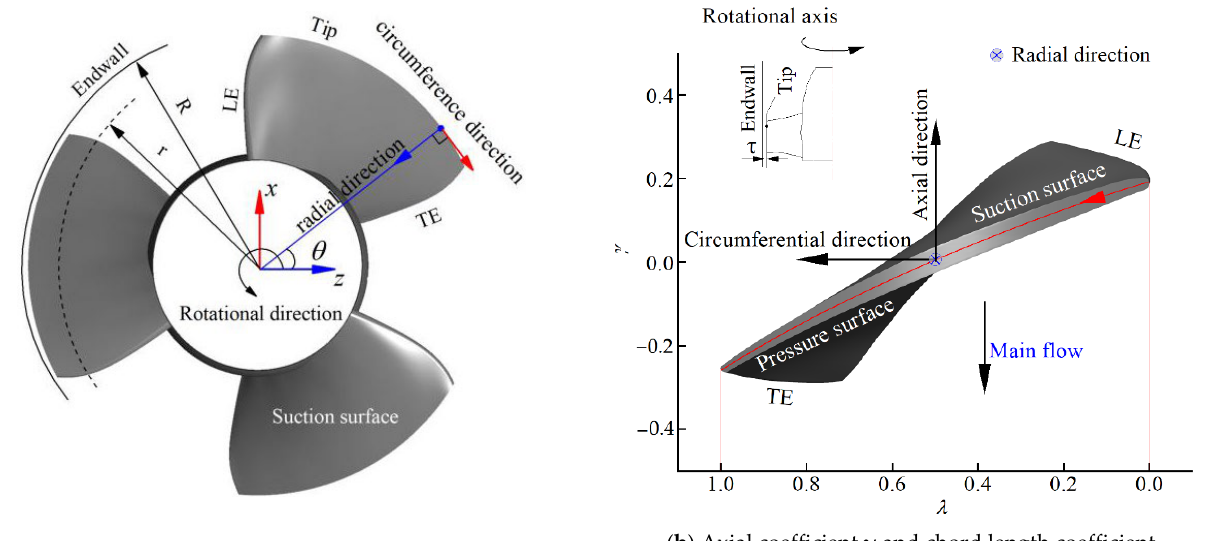
Figure 2. ( a , b ) Geometric definition of the impeller.